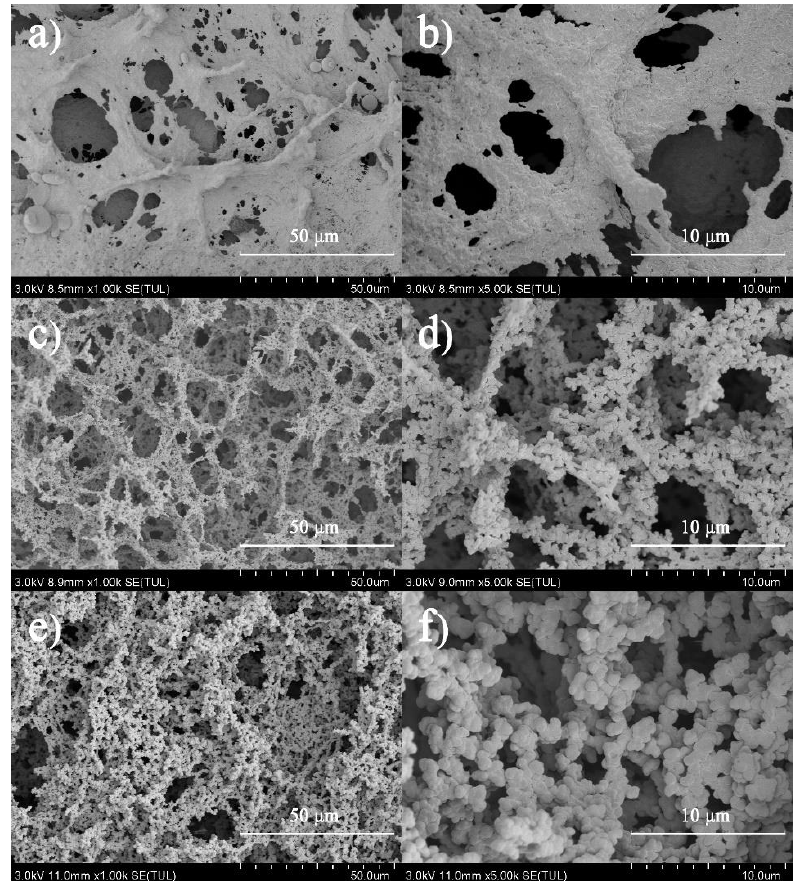
Figure 1. Scanning electron micrographs of the heat-set whey protein gels containing different CaCl 2 concentrations with different magnifications. ( a ) 10 mM CaCl 2 , 1000×; ( b ) 10 mM CaCl 2 , 5000×; ( c ) 15 mM CaCl 2 , 1000×; ( d ) 15 mM CaCl 2 , 5000×; ( e ) 50 mM CaCl 2 , 1000×; ( f ) 50 mM CaCl 2 , 5000×.